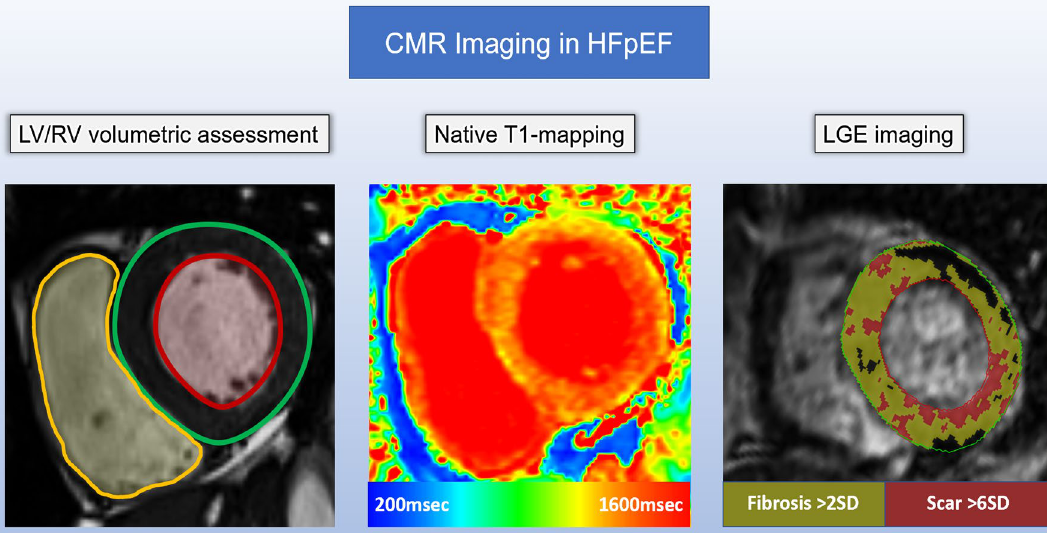
Figure 1. Central illustration to demonstrate the value of multiparametric cardiovascular magnetic resonance imaging for informing prognosis. In this case example, there is evidence of concentric LV hypertrophy on cine imaging, the native T1 is significantly raised throughout, and there are focal areas of scar and fibrosis on LGE